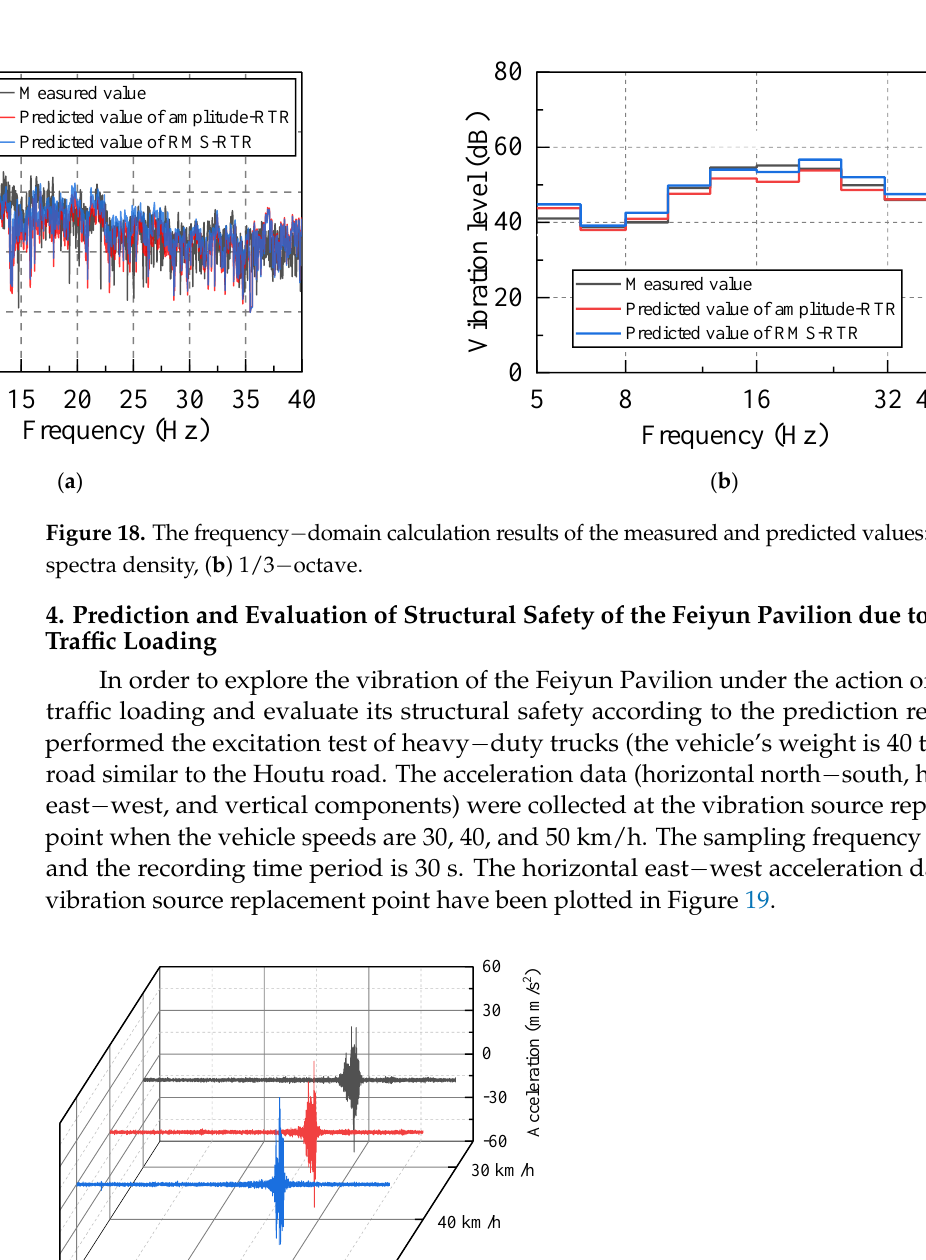
( b ) Figure 20. Predicted acceleration time − history of the third floor measuring point (D − P2) under the heavy − duty truck (horizontal east − west direction): ( a ) third floor measuring point (D − P2) accelera- tion time − history prediction based on the amplitude − RTR; and ( b ) third floor measuring point (D − P2) acceleration time − history prediction based on the RMS − RTR.